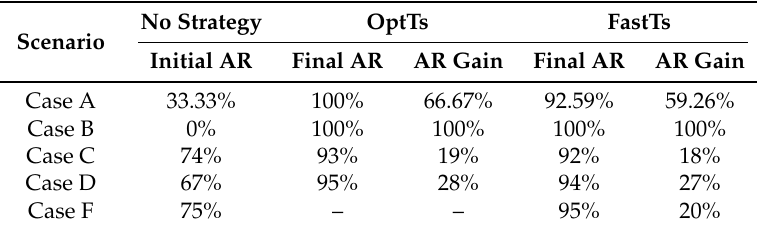
Table 7. AR metric for small-case